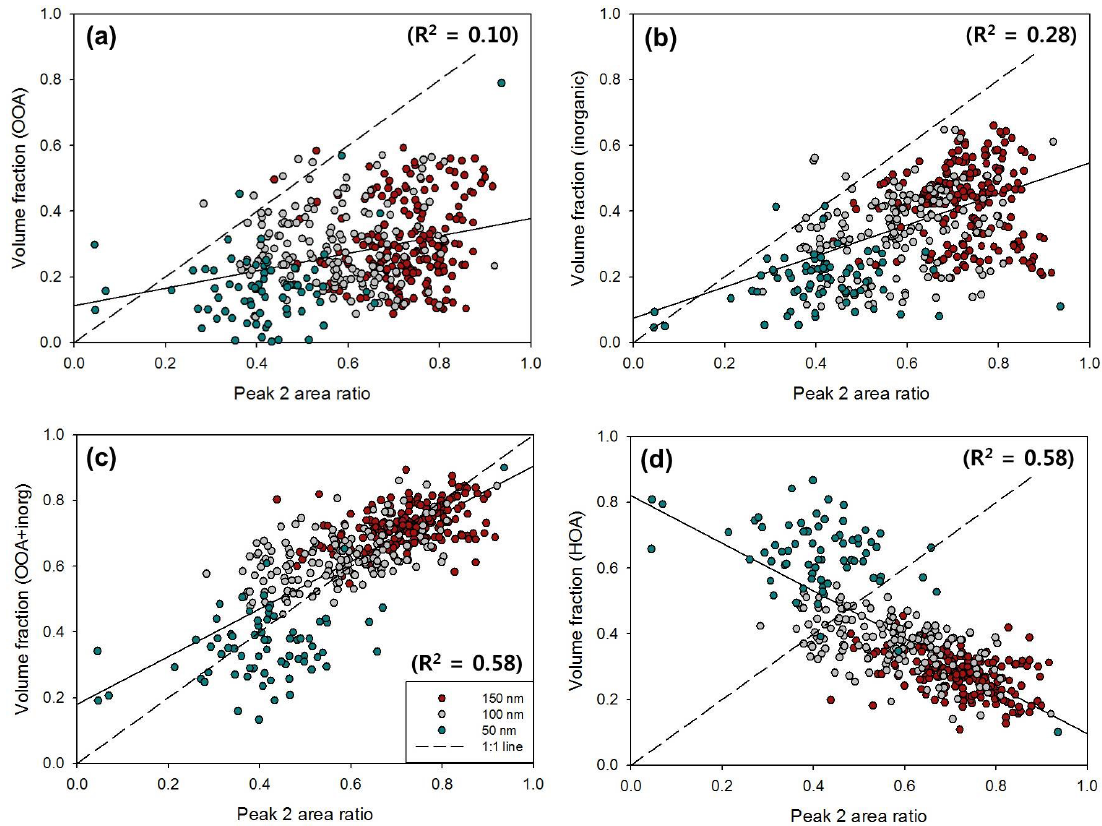
Figure 12. Scatterplots between Peak 2 (MH mode) area ratio and volume fraction of (a) OOA, (b) inorganics, (c) OOA plus inorganics, and (d) HOA for 50nm (turquoise), 100nm (gray), and 150nm (red) particles. The dashed line and solid line represent the 1:1 line and linear regression line, respectively. The coefficient of determination ( R 2 ) of each scatterplot is